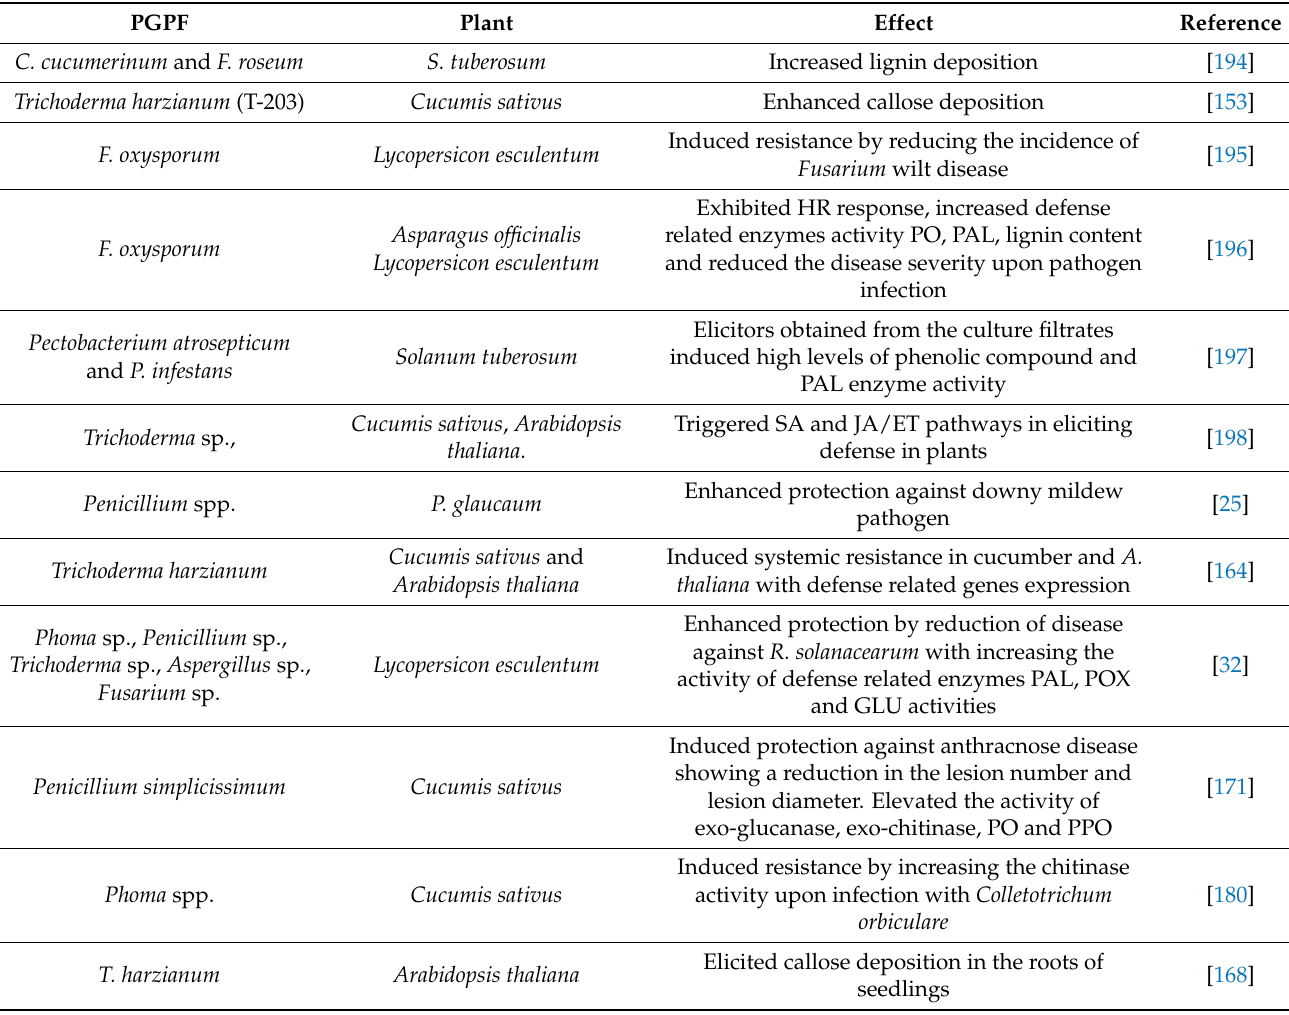
Table 2. Mechanism of resistance mediated by PGPF in different crop